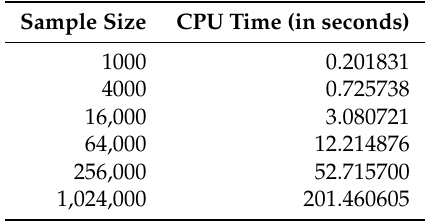
Figure 2. Inverted and numerical estimated curves of the distribution function. Table 2. CPU time of the exact simulation